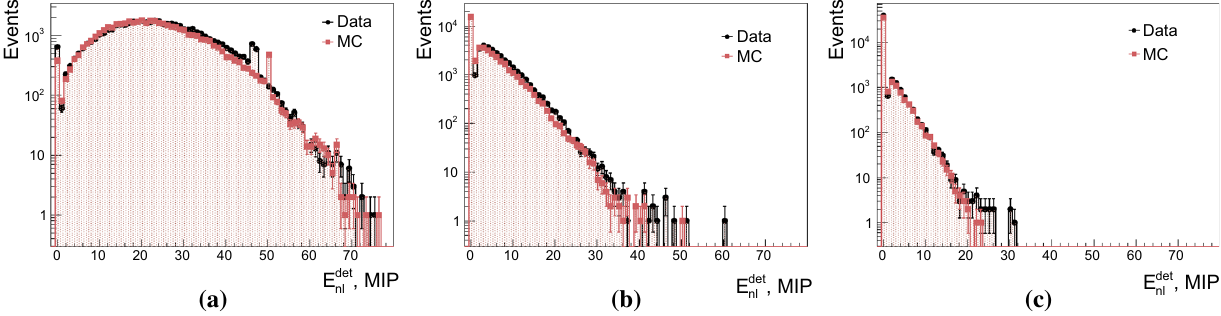
Fig. 18 Distributions of deposited energy E det as defined in Eq. (7) pads away from the core ( b ) and five pads away from the core ( c ). The nl summed over two sensor sectors L1 and R1 in a layer after seven tung- distributions are obtained with a 5 GeV electron beam sten plates for radial pads which correspond to shower core ( a ), two